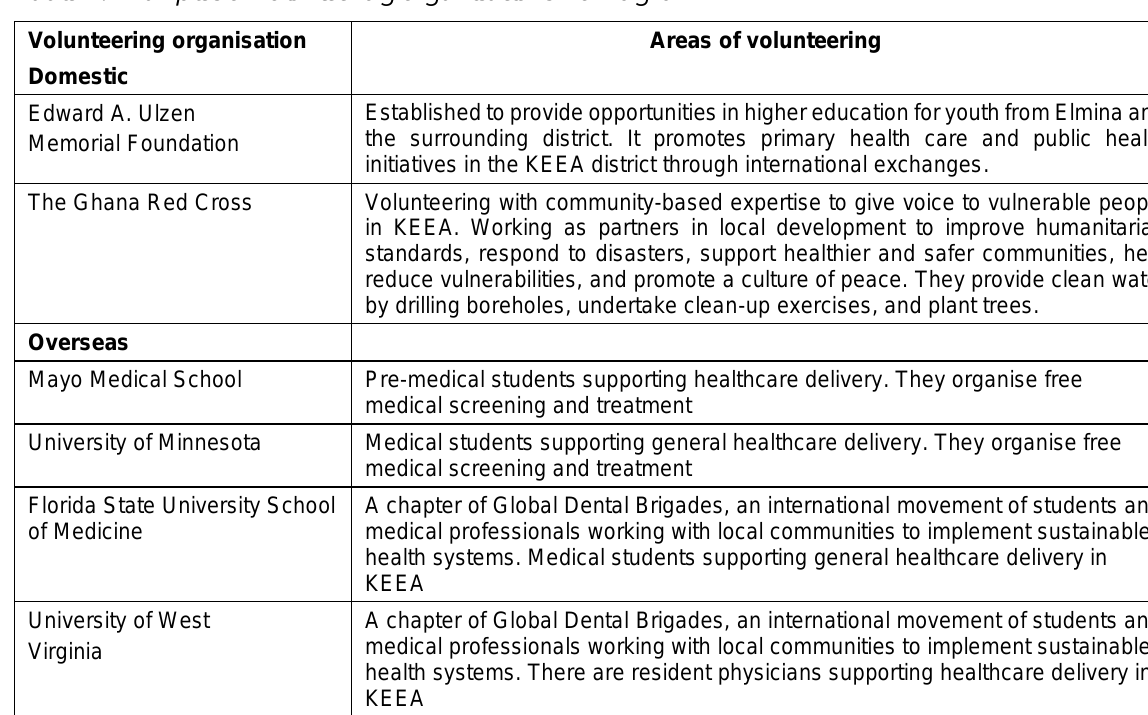
Table 1: Examples of volunteering organisations working in